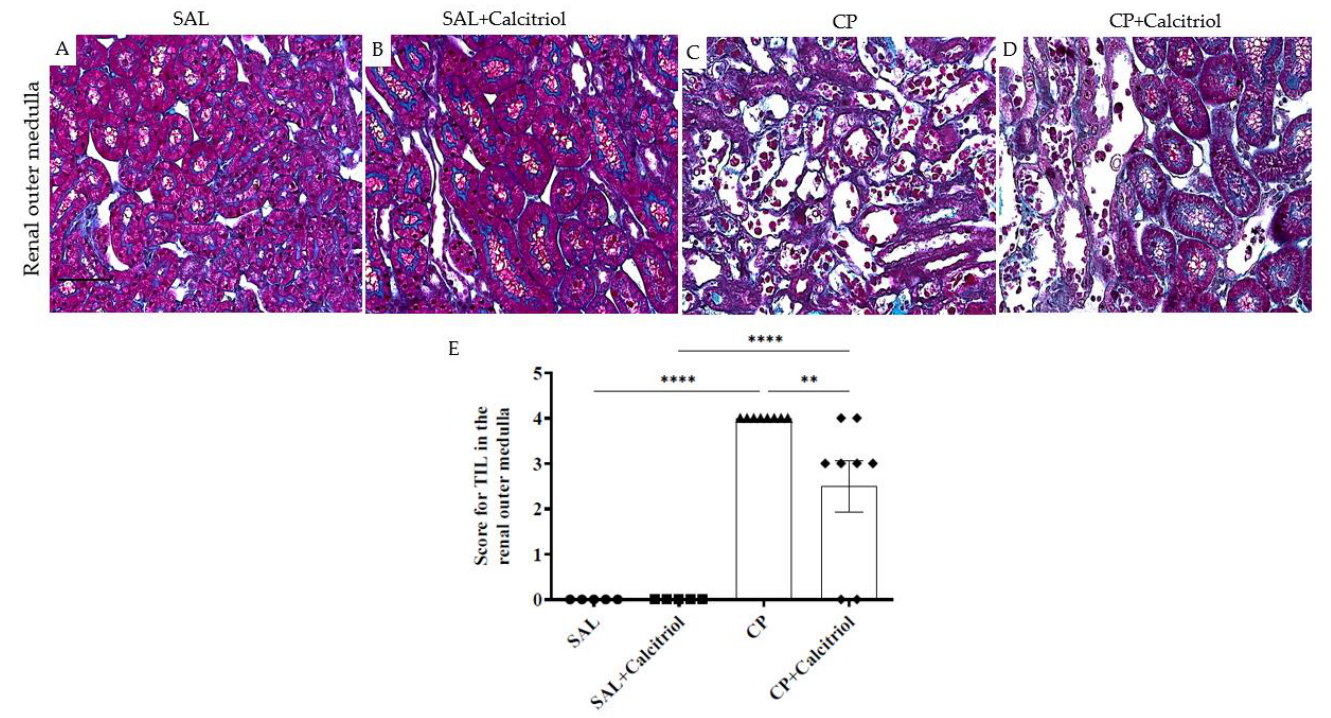
Figure 1. Histological sections stained with Masson’s Trichrome representative of the renal outer medulla of groups SAL ( A ), SAL + calcitriol ( B ), CP ( C ) and CP + calcitriol ( D ) (bar represents 50 µm). The score for TIL in the renal outer medulla ( E ) of all experimental groups. Data are expressed as mean ± SEM ( n = 5 – 8 for each group). ** p < 0.01; **** p < 0.0001 ×400.